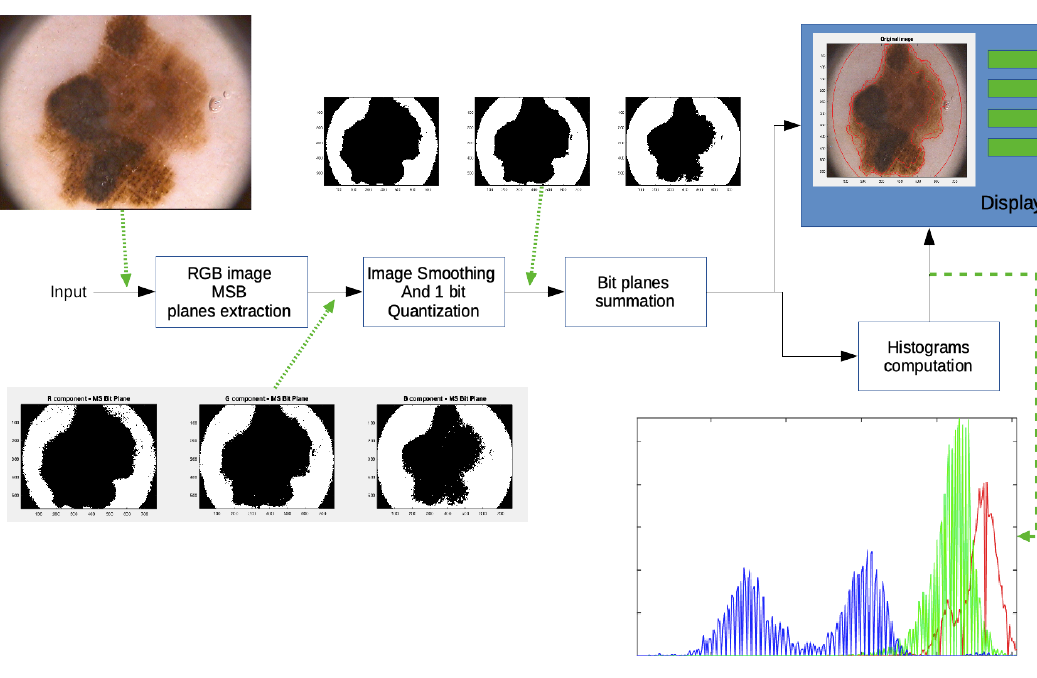
Figure 2. Block diagram of the conceived